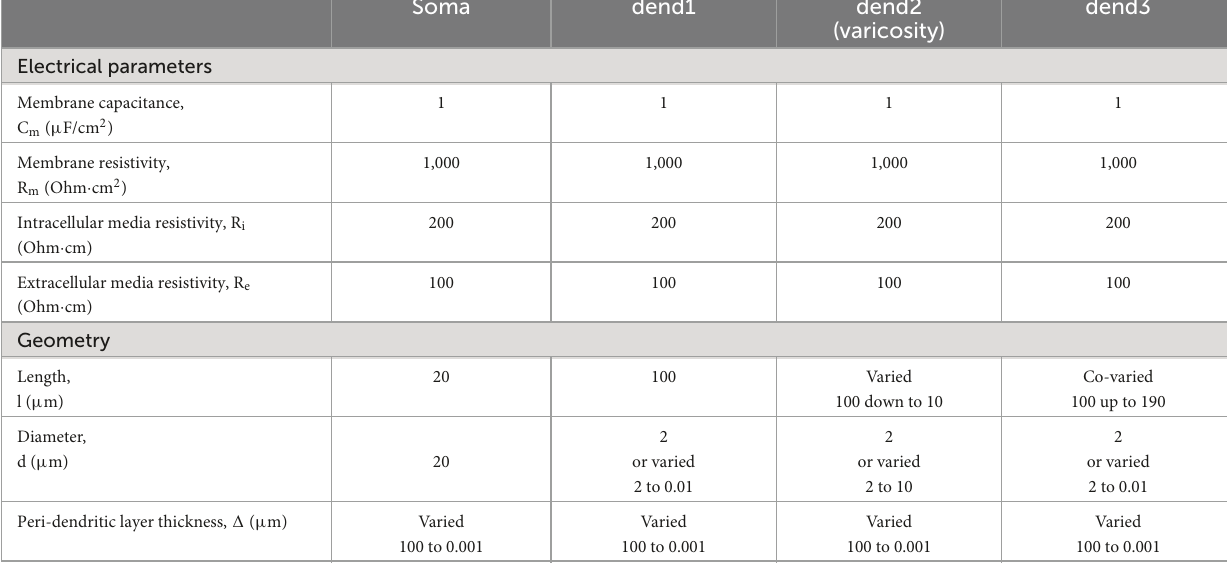
Soma dend1 dend2